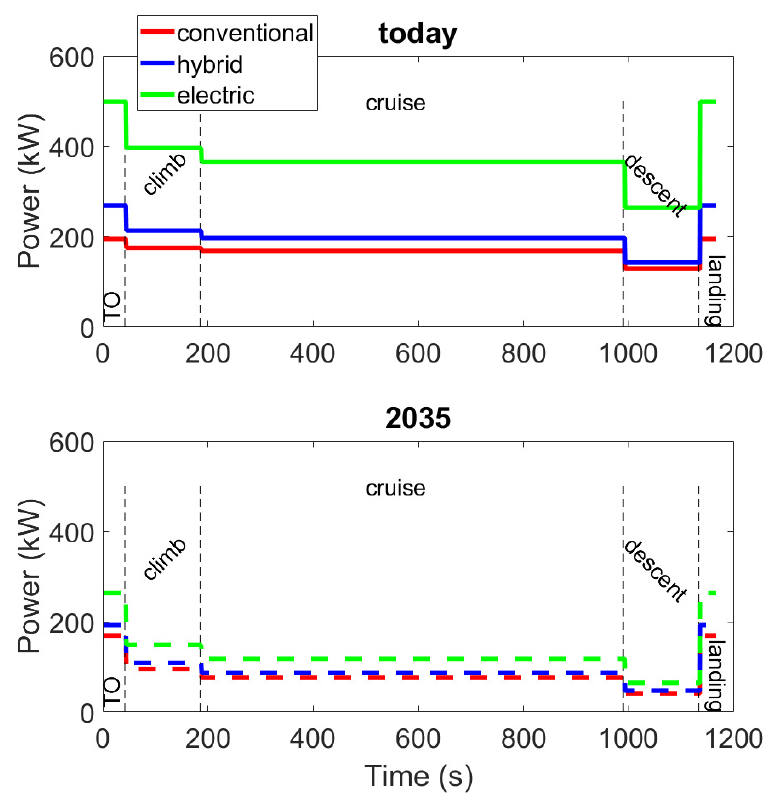
Figure 2. Power request of the three configurations with current and 2035 technology.